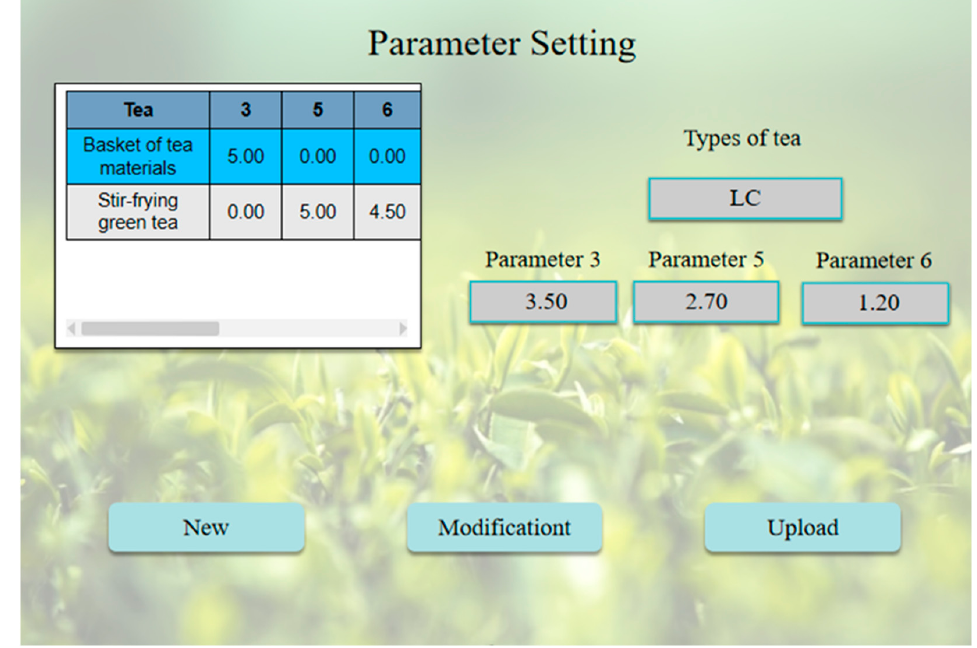
Figure 12. Parameter recording